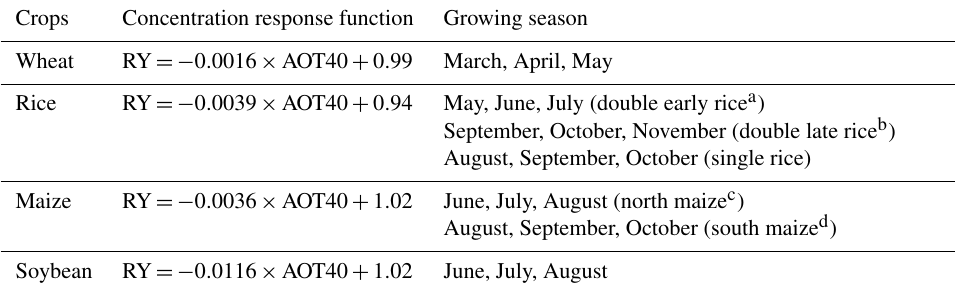
Table 1. Overview of the concentration–response function for the relative yields (RY) for ozone exposure on different crops. Crops Concentration response function Growing season Wheat RY =− 0 . 0016 × AOT40 + 0 . 99 Rice RY =− 0 . 0039 × AOT40 + 0 . 94